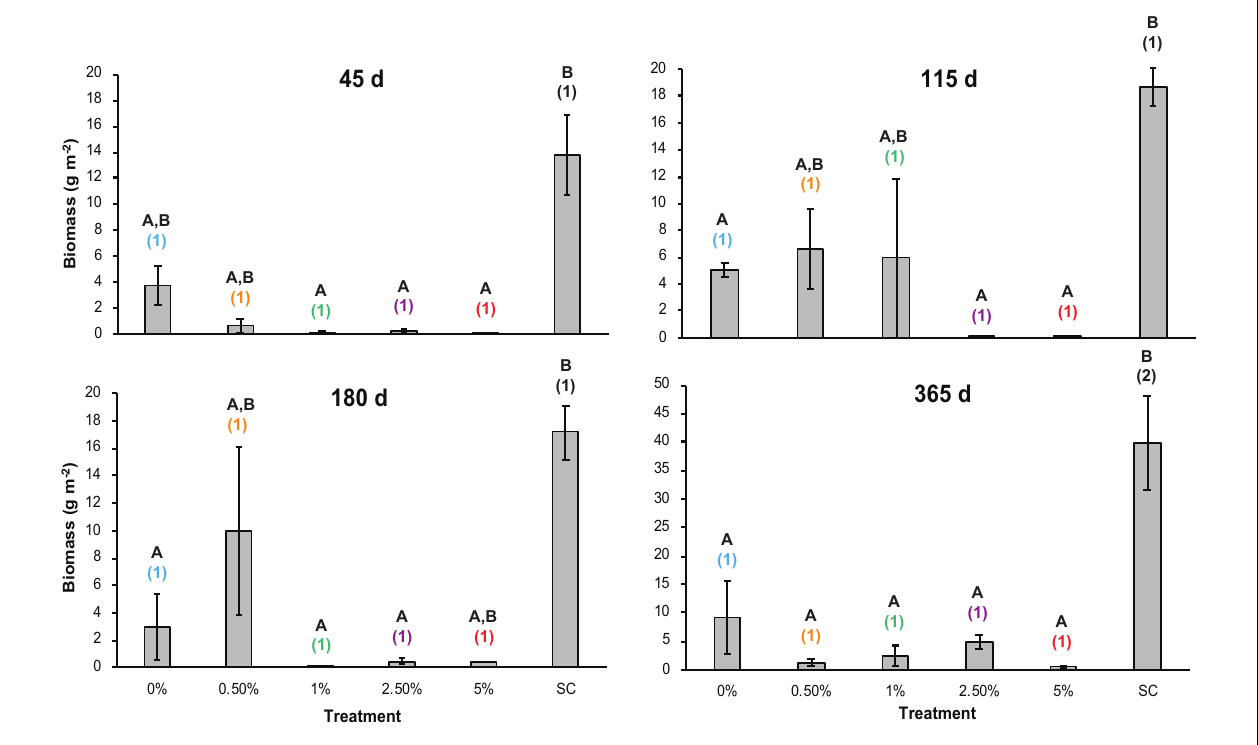
FIGURE 10 | Mean biomass (g per m 2 ) in the different treatments over time. Errors bars denote ± 1 standard error of the mean ( n = 3). Different letters denote significant differences ( p < 0.05) between the means of the treatments at each sampling point. Different colored numbers denote significant differences ( p < 0.05) between the means of a specific treatment at different sampling times. Colors used for the different treatments are the same as used in Figure 2 to aid clarity.